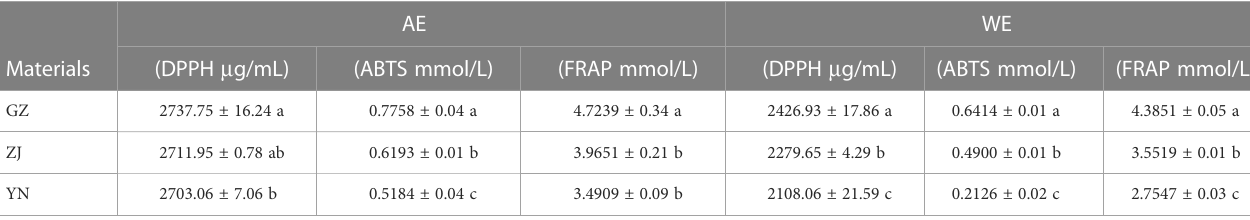
AE are alcohol extraction methods; WE are water extration methods. DPPH, 2,2-diphenyl-1-picrylhydrazyl radical scavenging ability; ABTS, 2,2 ’ -Azinobis- (3-ethylbenzthiazoline-6-sulphonate; FRAP,ferricreducingantioxidantpower.IfthevalueofABTSandFRAPfromtheextractis1mM,theantioxidantcapacityisequivalentto1mMTrolox.Differentlettersfollowedthenumbersindicate statistically signi fi cant differences (p < 0.05). Values are expressed as the mean ± SD, on a dry